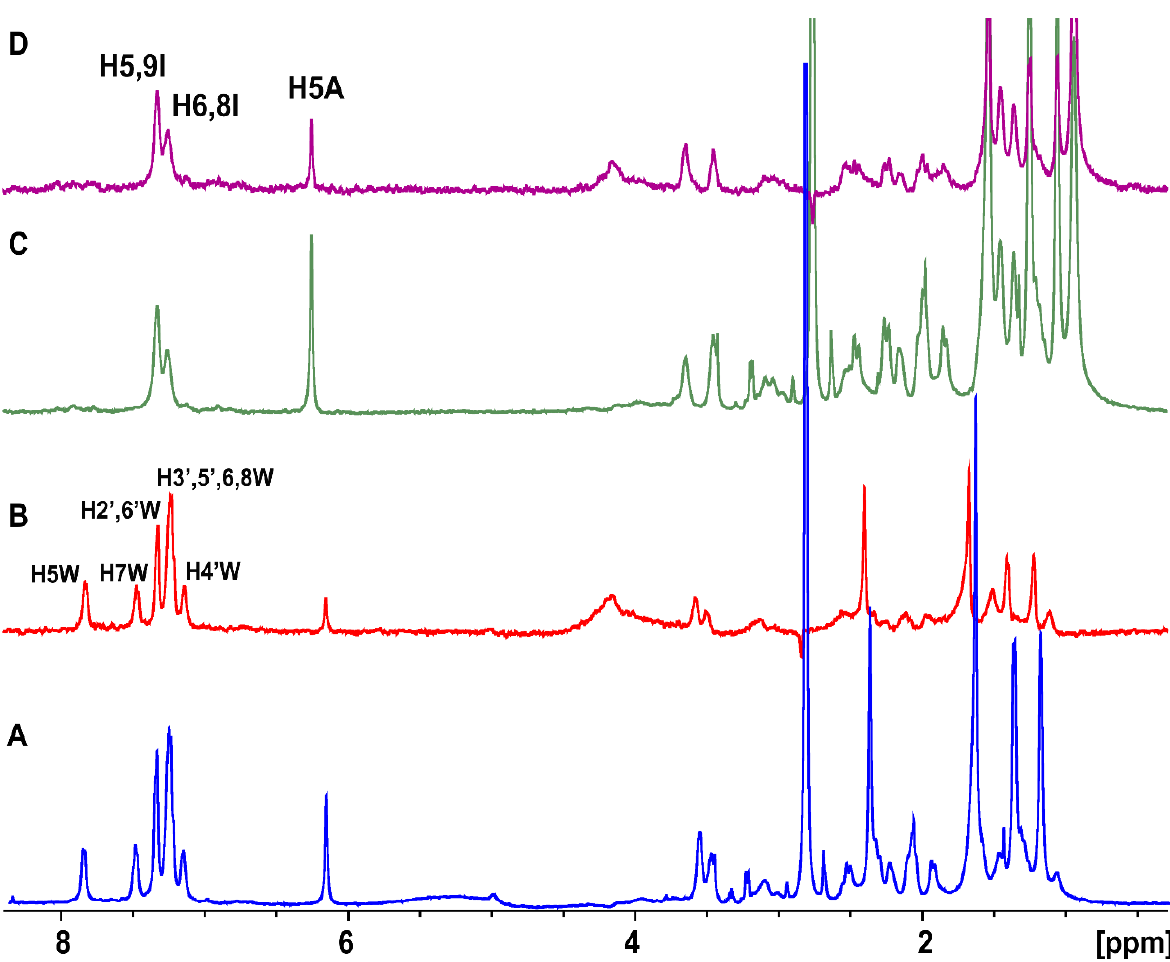
Figure 6. ( A ) 1 H NMR of 2 mM artemisinin and 1.8 mM of warfarin with 20 μΜ of BSA in PBS buffer